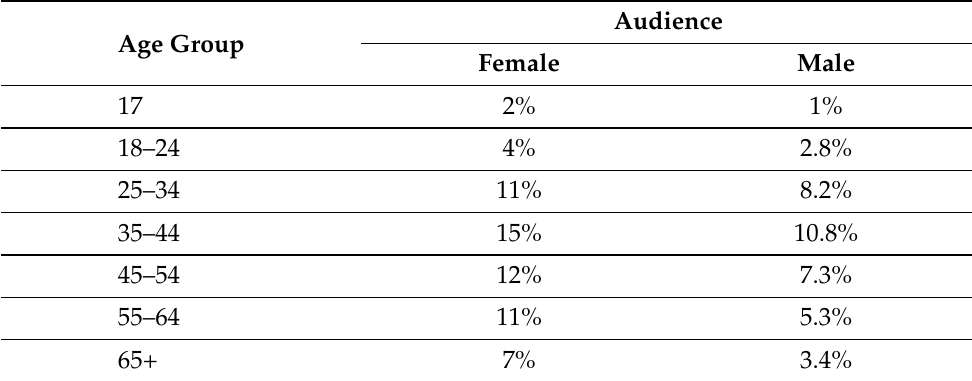
Table 1. Gender distribution for Odnoklassniki audience in 2021. Source: